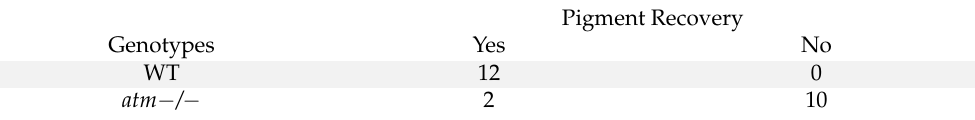
Table 1. Statistics of pigment recovery in WT and atm − / − fish after